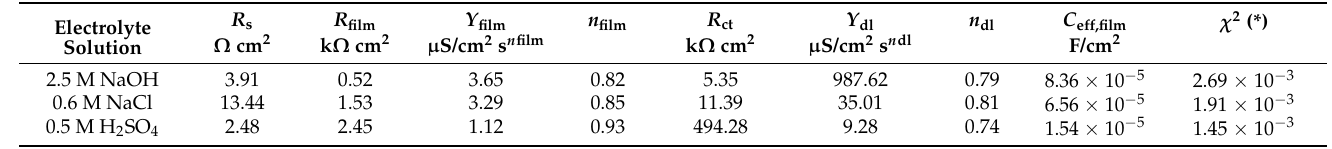
Table 5. Fitting EIS parameters for Al 10 Cr 30 Fe 25 Mn 30 Ti 5 HEA exposed to different pH electrolyte solutions at RT.